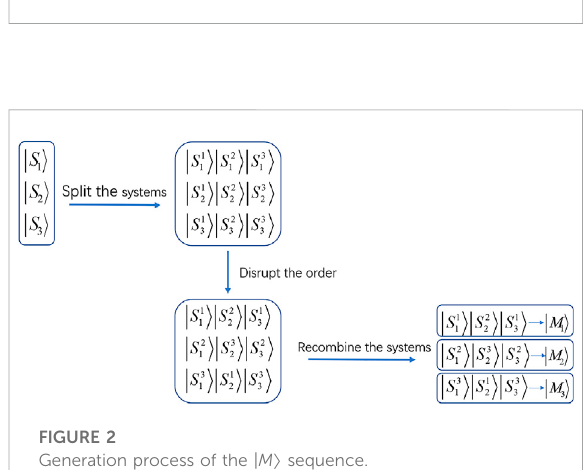
FIGURE 1 Communication in N a and N b i .